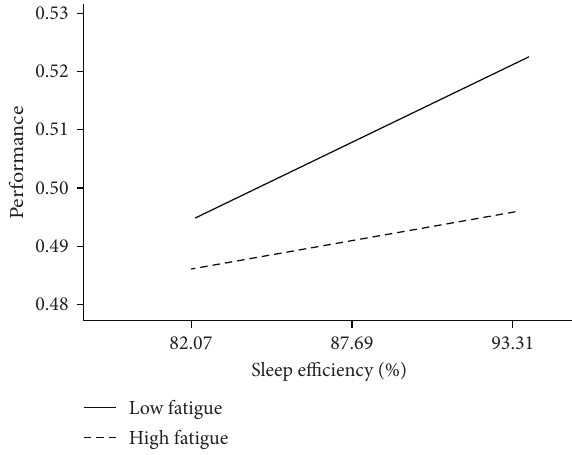
Figure 3: Moderating effect of fatigue on the association between performance and sleep efficiency.